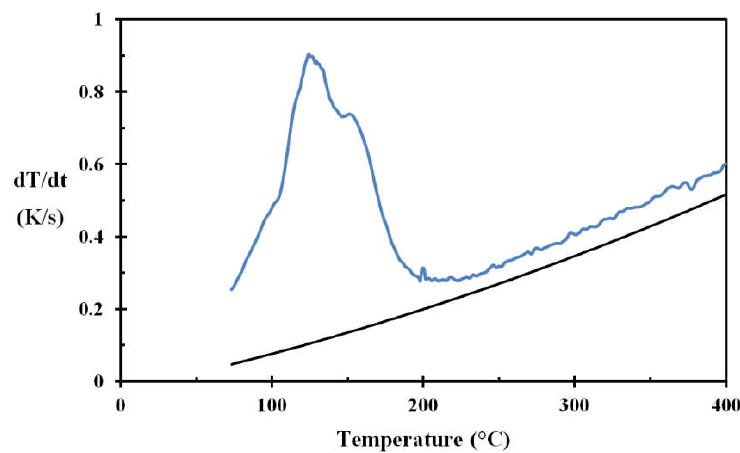
Figure 5. Cooling rate, dT / dt , for droplet application ( blue ) and reference recordings ( black ) based on temperature data from Figure 4.